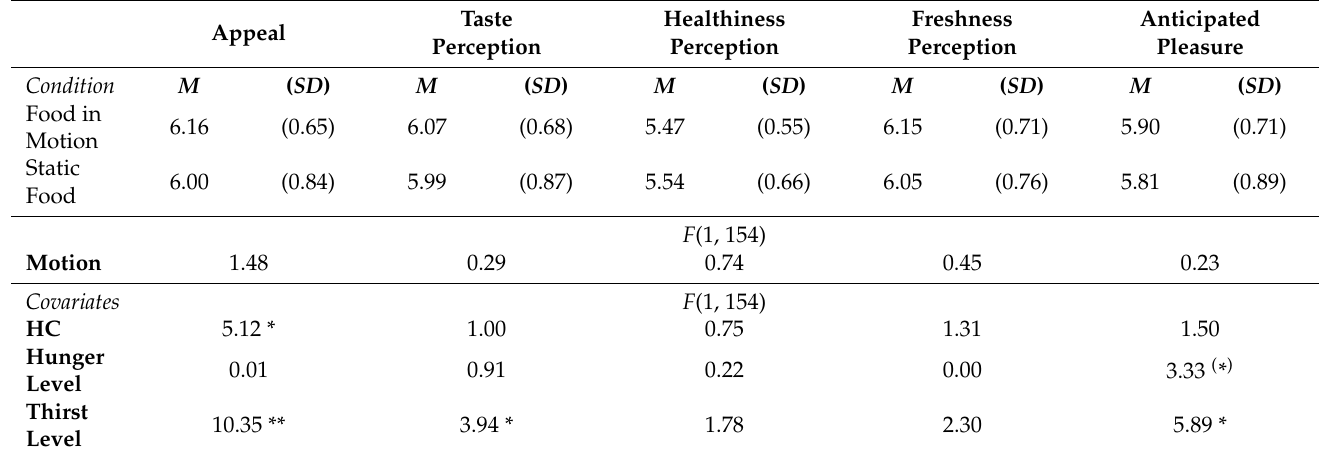
Table 3. Descriptives and multilevel results from the main effects in Study